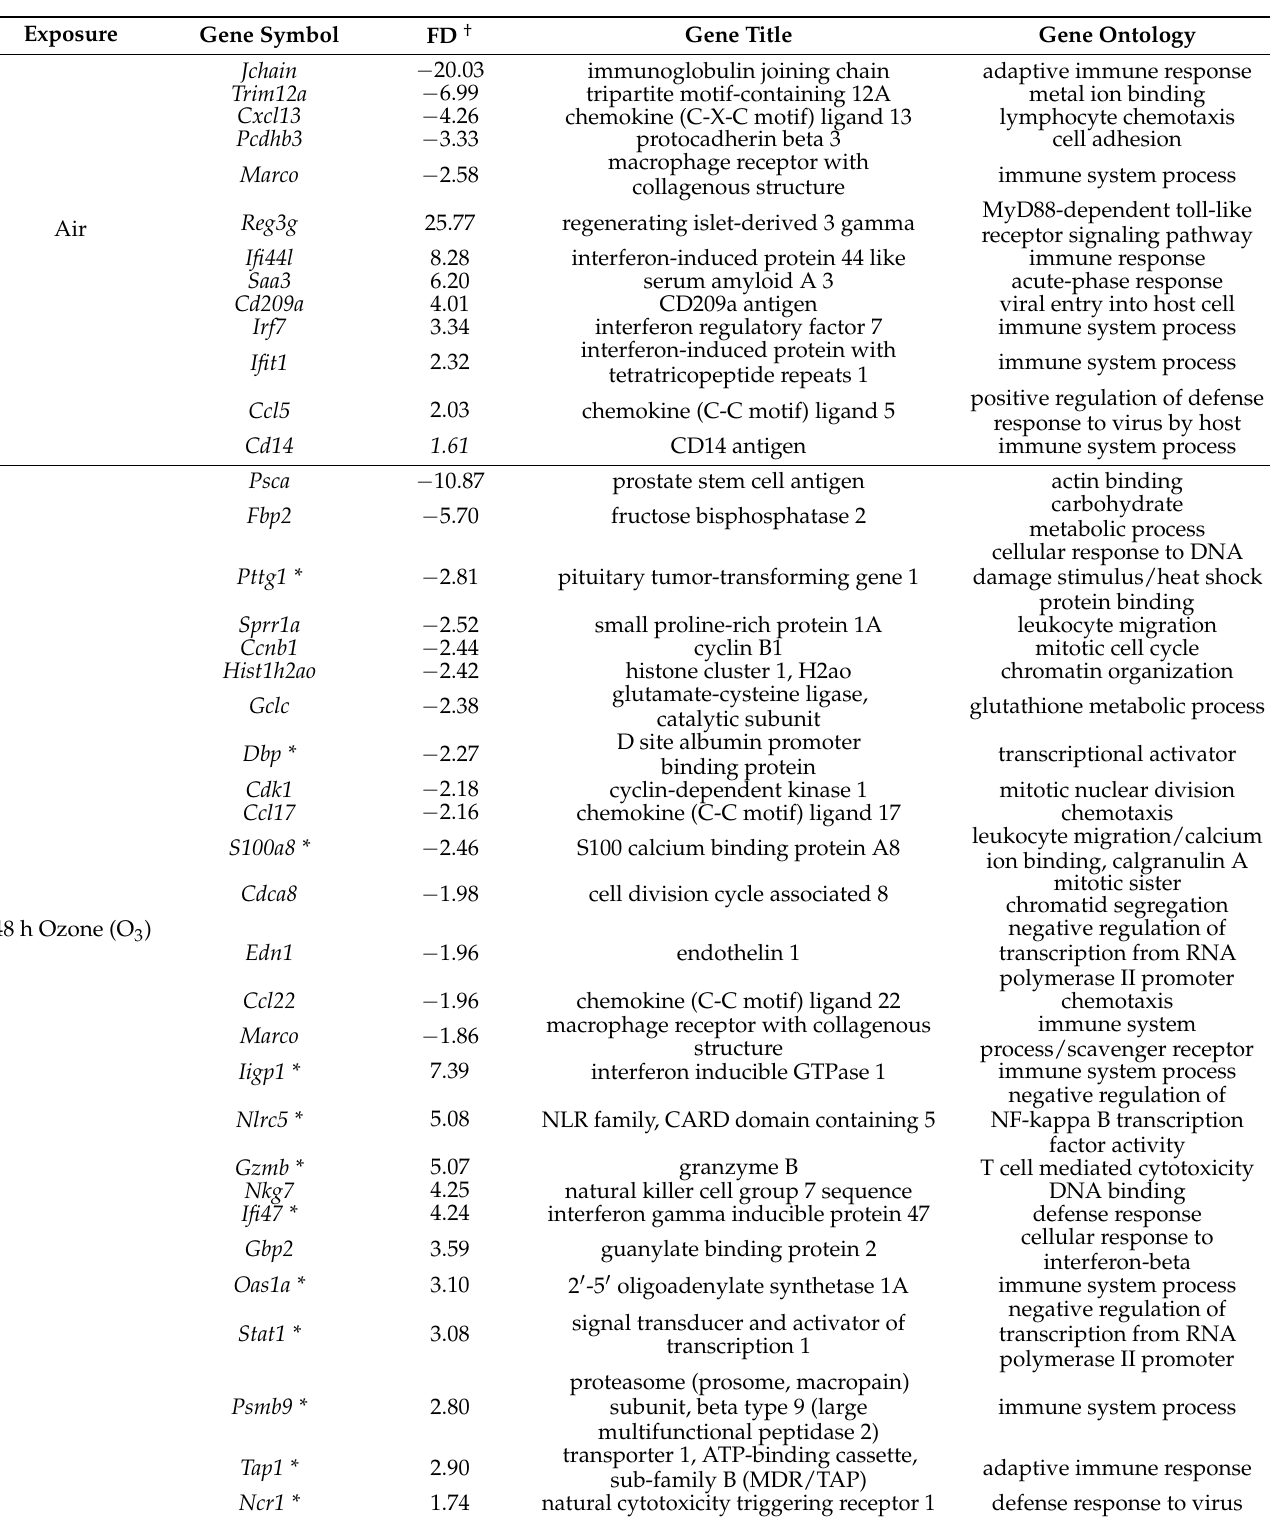
Table 4. Selected nuclear factor of kappa light polypeptide gene enhancer in B-cells p50 (NF- κ B1)-dependent lung genes after air or ozone (O 3 )